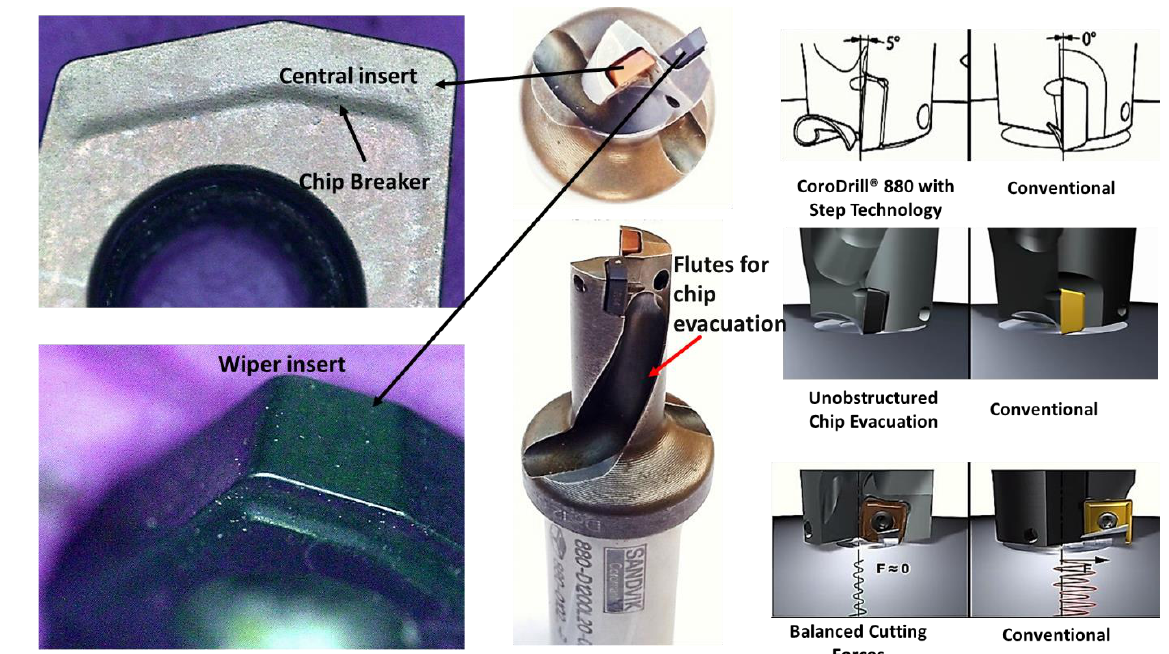
Figure 2. View of Coro Drill 880 fitted with a central and a peripheral (wiper) insert.